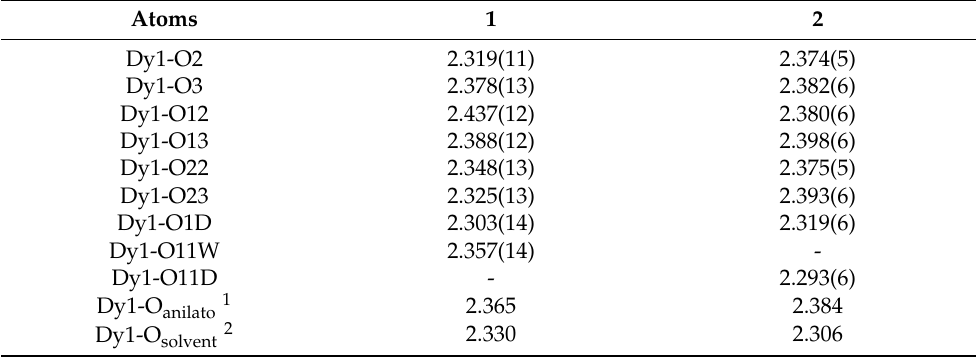
Table 1. Dy-O bond distances (in Å) for compounds 1 and 2 .